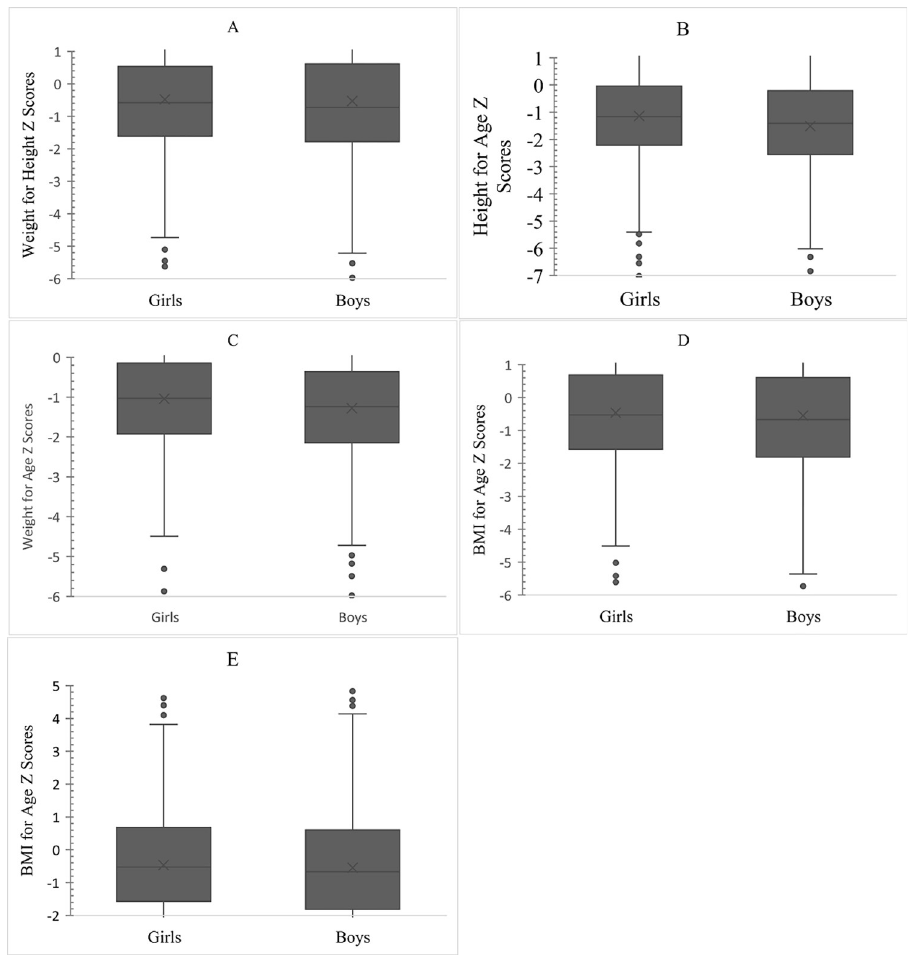
Fig 2. Gender wise distribution of nutritional indicators. A. Weight for Height (Wasting) B. Height for Age (Stunting) C. Weight for Age (Underweight) D. BMI for Age (BMI Wasting) E. BMI for Age (Overweight and